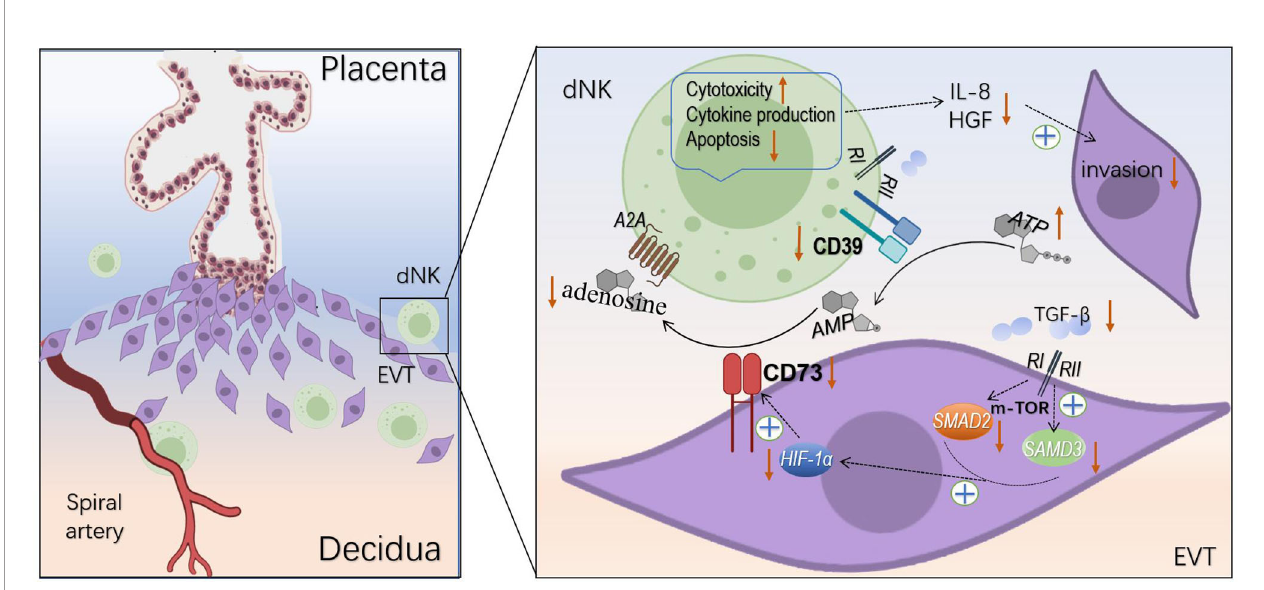
FIGURE 8 | Regulation of dNK cells and EVT cells by CD39 and CD73. CD39 and CD73 hydrolyze ATP to adenosine changed dNK cells cytotoxicity, apoptosis, cytokine production, and impaired invasion of EVT cells. TGF- b induces the expression of CD73 on the EVT cells via mTOR-HIF-1 a